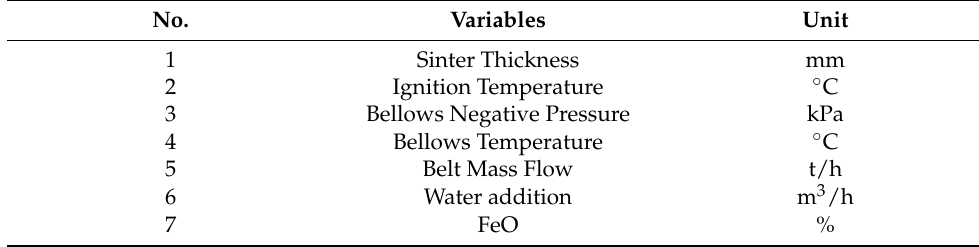
Figure 9. Brief flowchart of DCS. Table 2. Part of the collected original